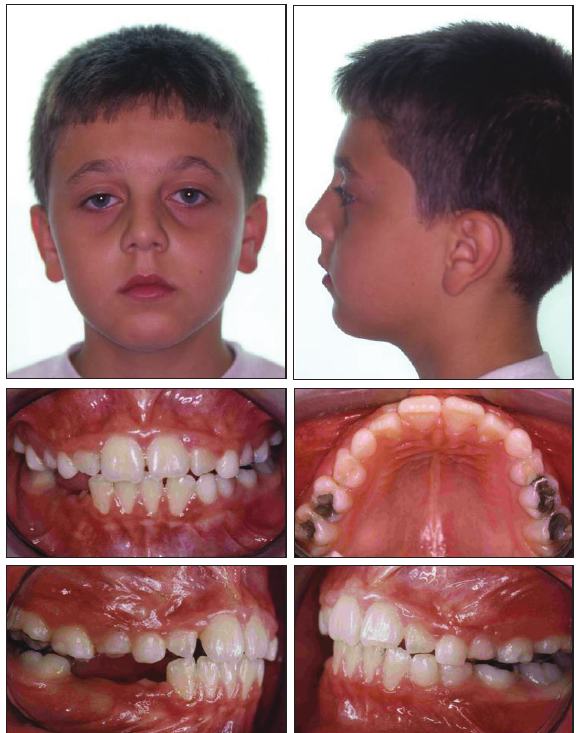
Figure 3. Intra-oral and extra-oral photographs of a patient after expansion procedure.